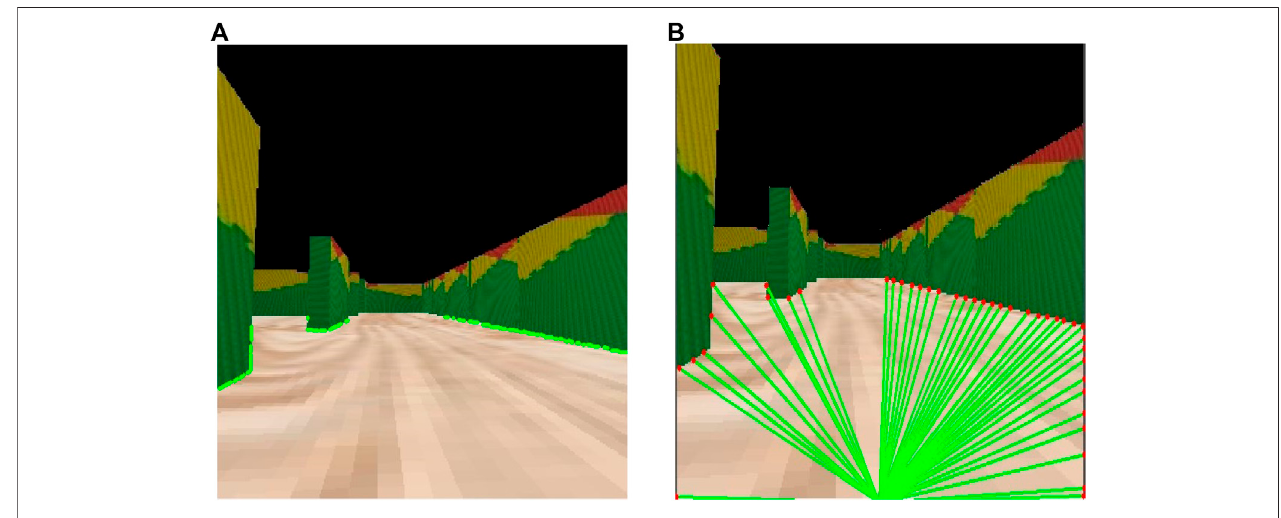
FIGURE 4 | Comparison of line and corner algorithms. (A) Line detection algorithm performance. (B) Corner detection algorithm performance.